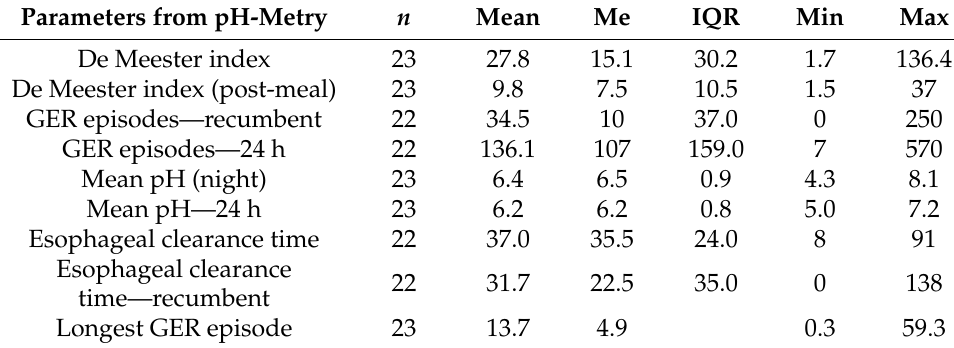
Table 3. Distribution of esophageal pH monitoring